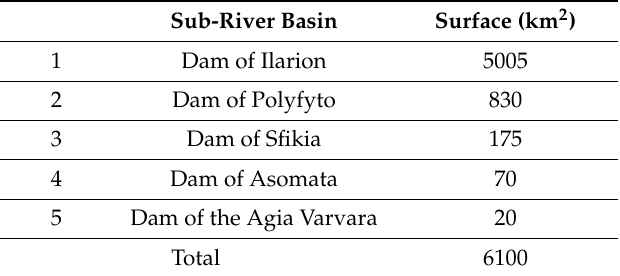
Figure 1. The catchment area of the Aliakmon River upstream of the Agia Varvara dam. Table 1. Aliakmon River catchment areas, upstream of the Agia Varvara dam.